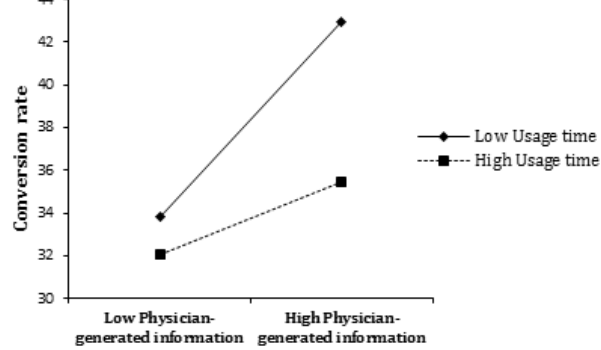
Figure 5. The moderating effect of usage time on physician-generated information and the conversion rate.